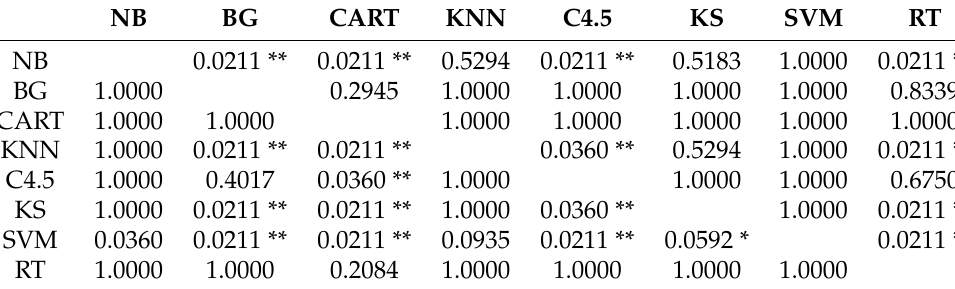
Table 18. Pairwise WSR test for kappa statistics of adolescents.